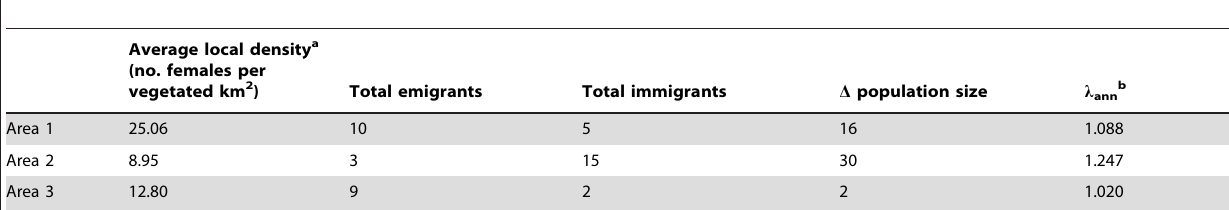
Table 3. Density and population growth characteristics of female horses in areas 1, 2, and 3 (west to east) on Sable Island, Canada (June–September 2008–2010).